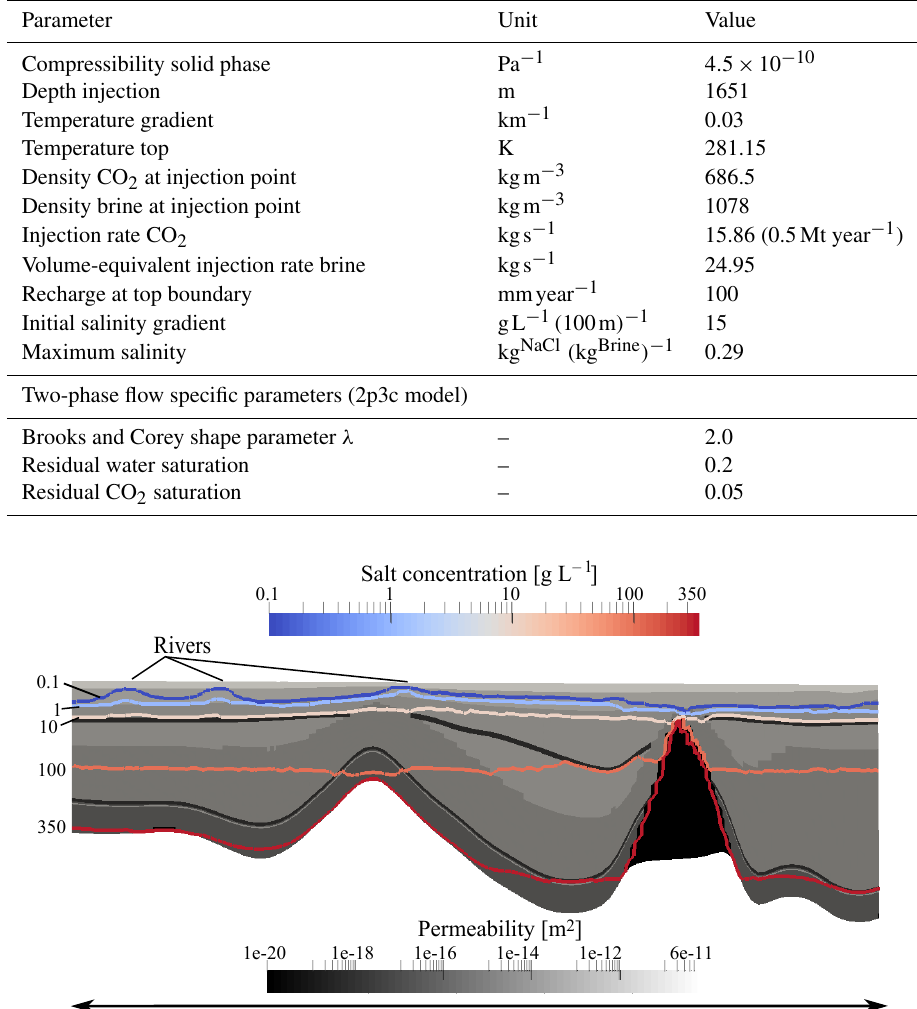
Table 3. List of parameters for the reference setting. The two-phase flow specific parameters are only required for the 2p3c model.